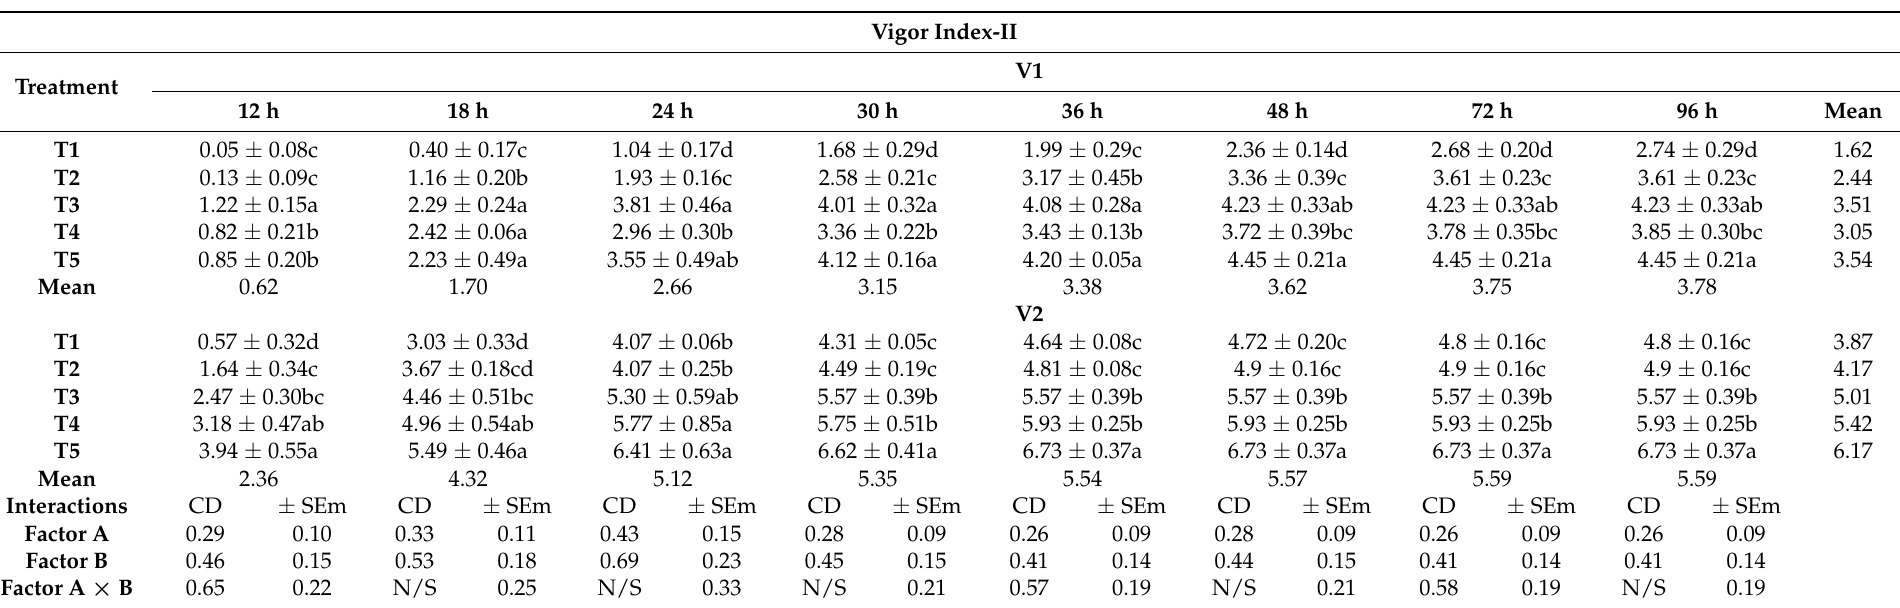
Table 3. Vigor index-II of wheat varieties under Mg(NO 3 ) 2 , ZnSO 4 , Mg(NO 3 ) 2 + ZnSO 4 primed, and nonprimed (control) seed